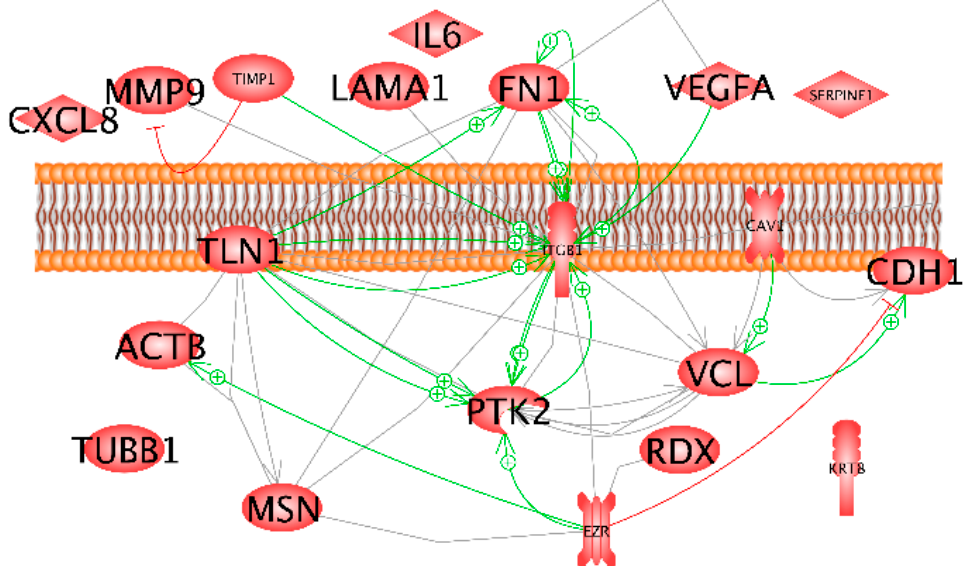
Figure 9. Interaction and localization of proteins detected in the cells by Western blot (red margins). Solid lines indicate the bond. Filled arrows show the directional interaction and dashed arrows show the influence. + Signs indicate activity − inducing effect and red lines indicate inhibition. FN1, VEGFA, TLN1 and TIMP1 proteins are positively influencing β 1 -integrin which is inducing PTK2 and fibronectin. TLN1 is interacting with PTK2 and FN1 . Vinculin is activating E-cadherin, whereas ezrin has a negative influence on CDH1 . Moreover, TIMP1 is inhibiting MMP9 .